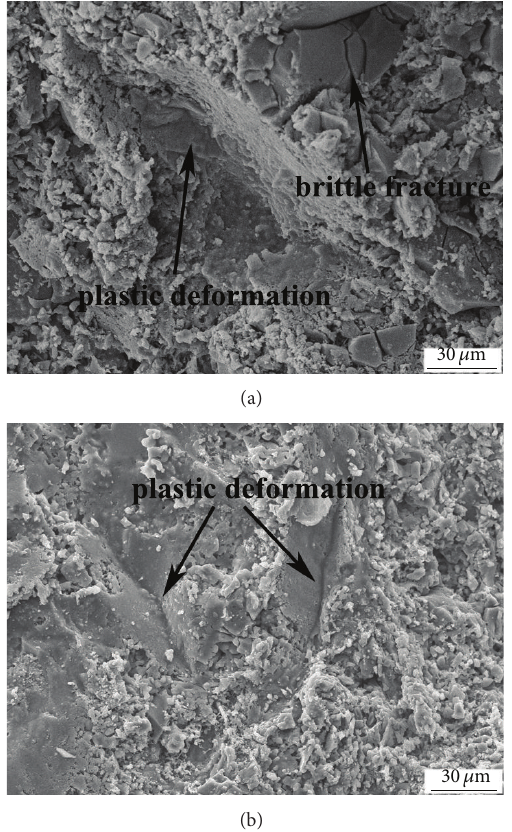
Figure 7: Representative SEM photography shows plastic deforma- tion of samples: (a) sample M1 (no silicon added) eroded at 1200 ∘ C and (b) sample M4 (12% silicon added) eroded at 1200 ∘